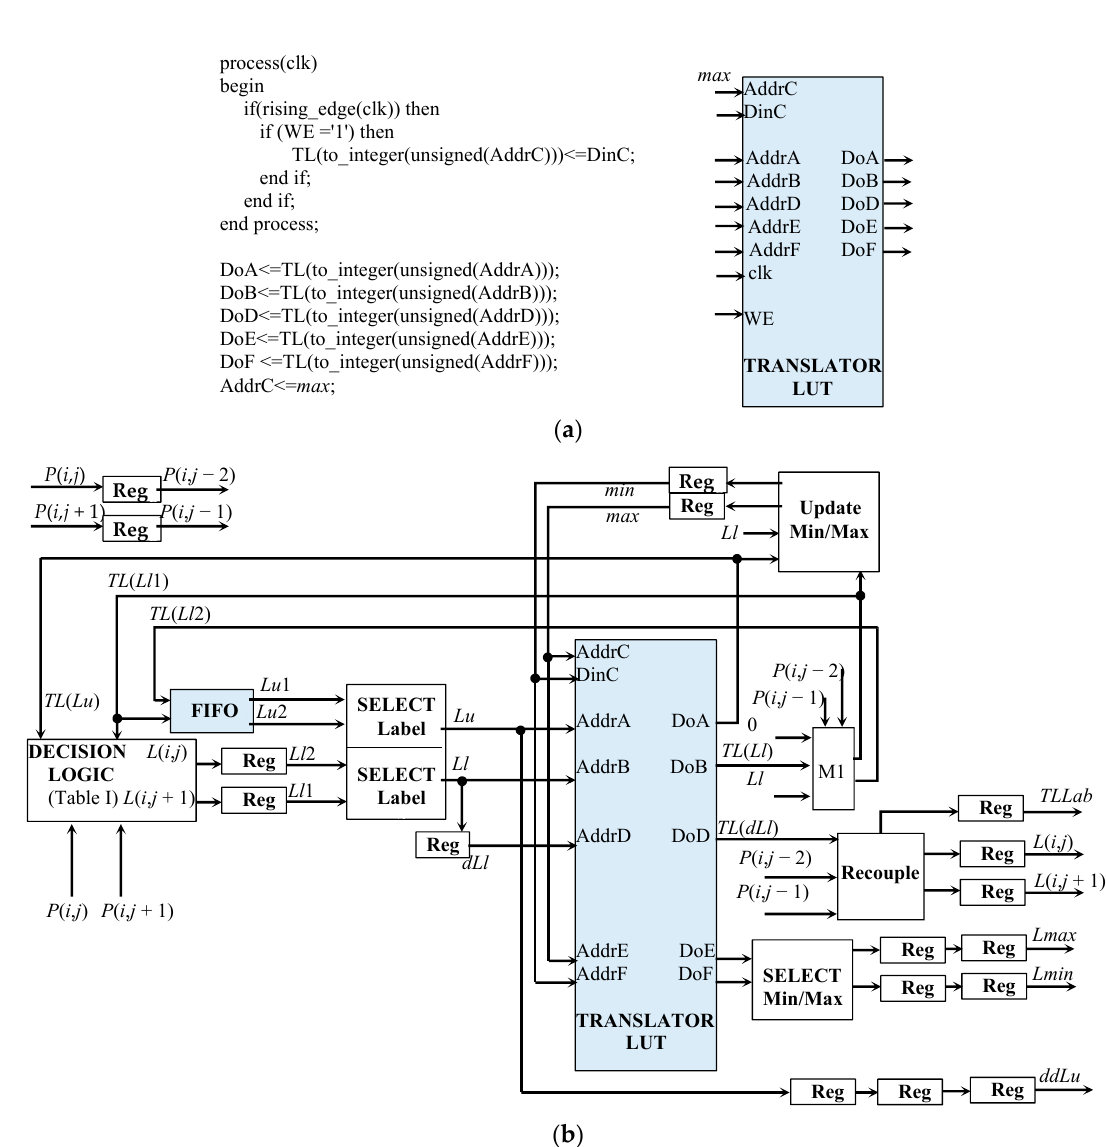
Figure 9. The hardware architecture of the PrLab module: ( a ) VHDL code of TL; ( b ) the schematic.